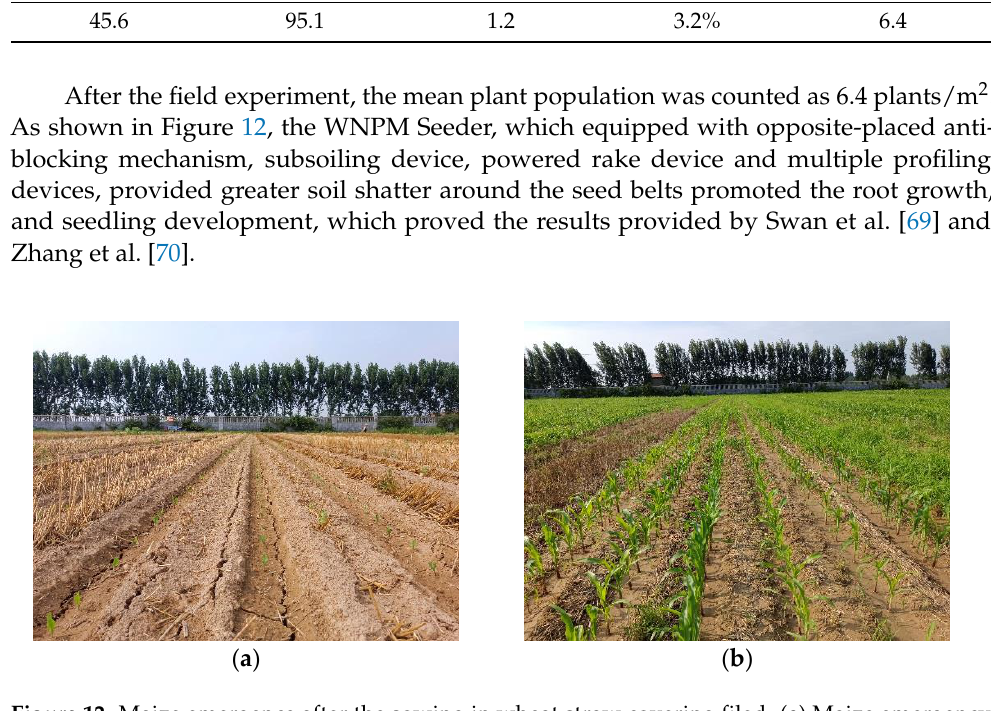
~7 days after seeding; ( b ) Maize growth, ~30 days after